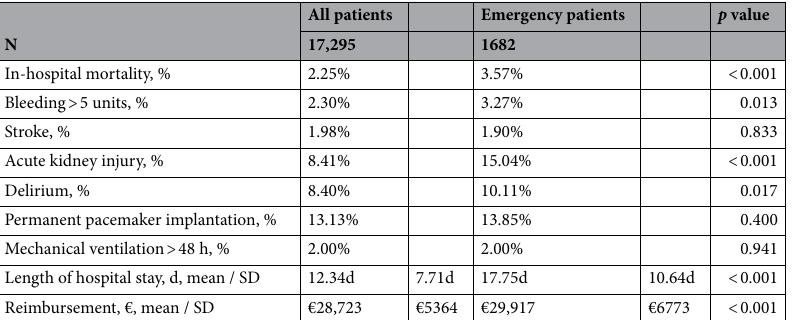
Table 2. Unadjusted in-hospital outcomes of patients with balloon-expandable or self-expanding TAVI in Germany in 2018. N: number of procedures; SD: standard deviation. p-values based on chi-square test or t-test, as